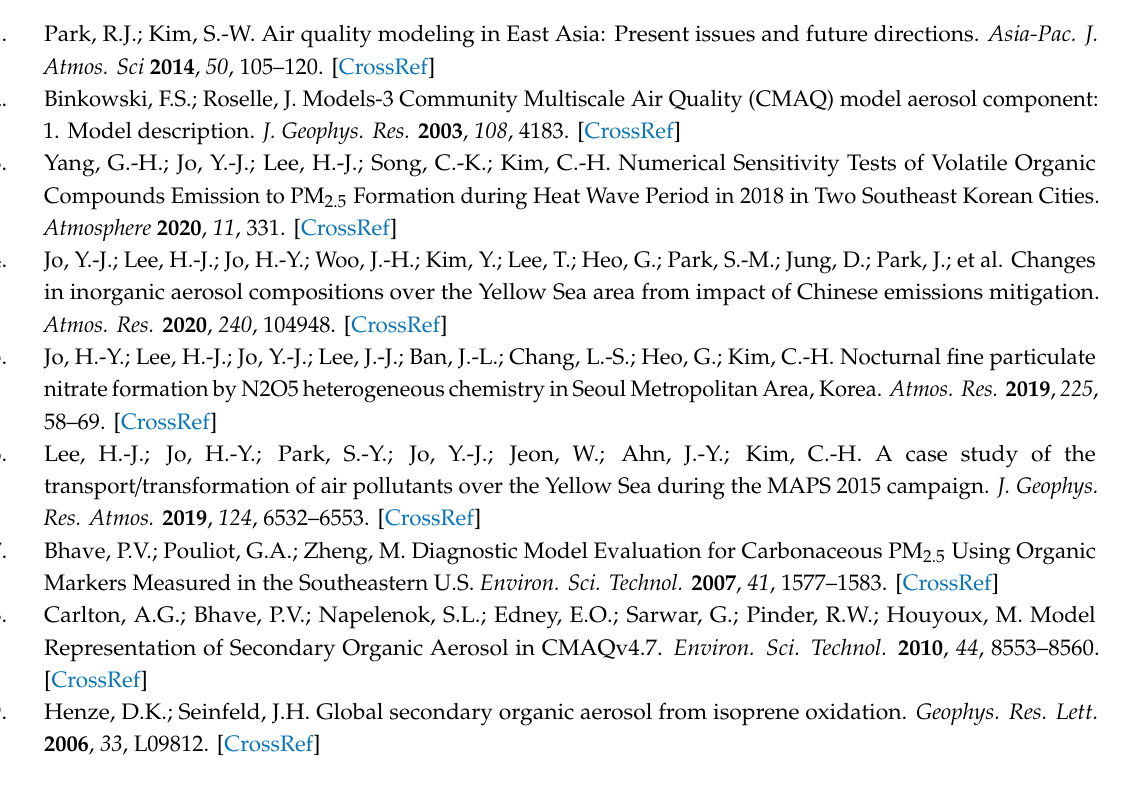
Table S1: Performance statistics of the WRF-Chem simulation for 2 m temperatures, 10 m wind speeds and relative humidity at Seoul and Baengnyeongdo, Figure S1: Spatial distributions of DC-8 observation and WRF-Chem results for OC and toluene concentrations along the DC-8 flight paths during STG cases (4 stagnant–dominant cases: 17, 18, 20 and 22 May 2016) and LRT cases (4 long–range transport dominant cases: 25, 26, 30 and 31 May